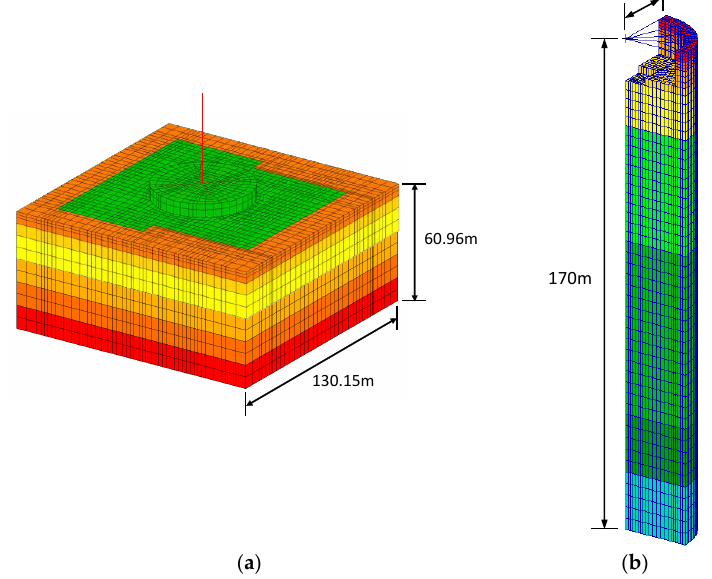
Figure 5. Numerical examples for evaluating the performance of the proposed CAF parallelization technique for frequency domain soil – structure interaction analysis: ( a ) Shallow foundation (number of nodes = 22,690); ( b ) Deep foundation (number of nodes = 45,137).